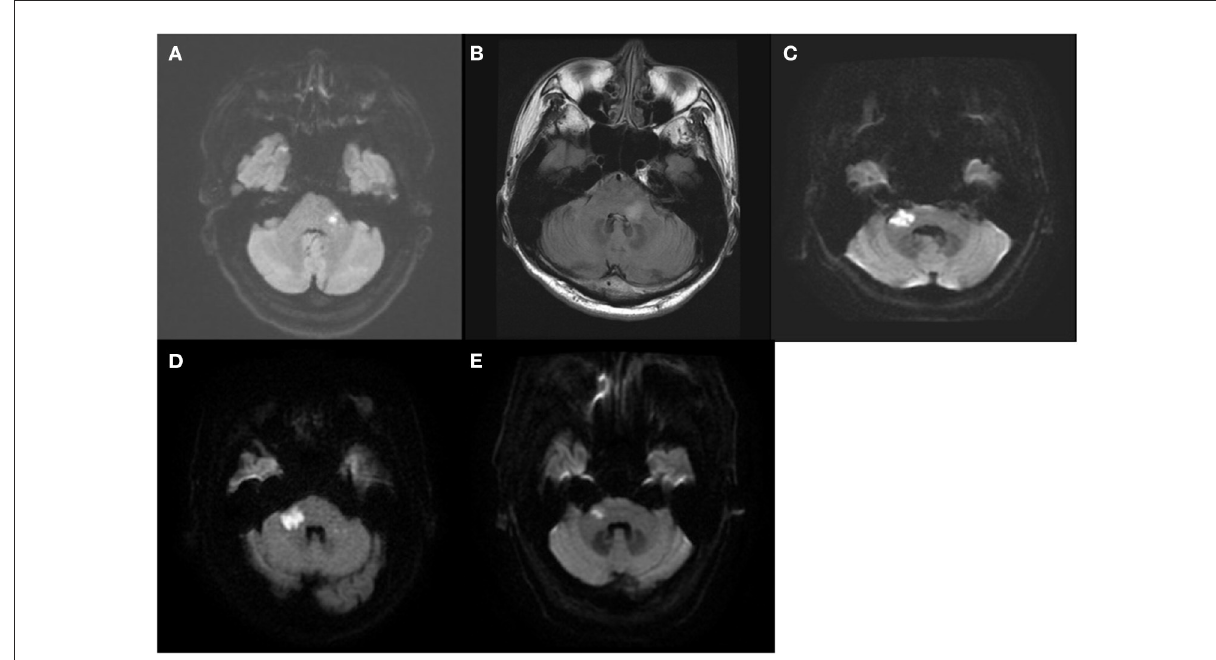
FIGURE1 The MRI findings of the five patients with posterior fossa lesion (MRI + group). Four had acute lateral pontine infarction (A,C–E) and one had acute demyelinating lesion in left lateral pons (B) .